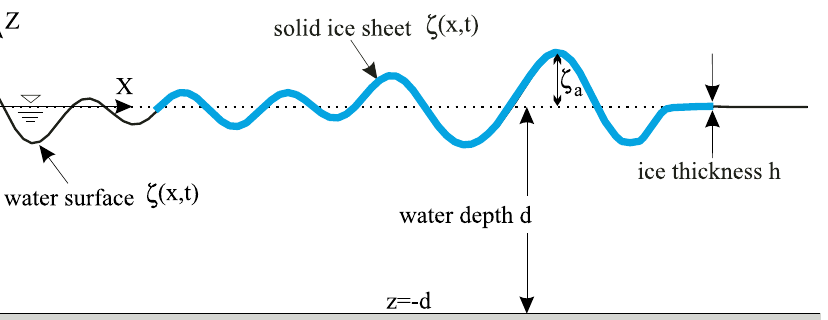
Figure 1. Definition of the coordinate system showing the profile of the x-z plane: The point of origin is at the still water level, the positive z-axis faces upwards, opposing the gravitational force, and the positive x-axis points to the direction of wave propagation assuming uni-directional waves. Note that the wave elevation in open water and the vertical displacement of the ice are assigned the same variable ζ , but as soon as a clear distinction has to be made between open water and ice-covered water, this is indicated by the indices i for ice and w for open